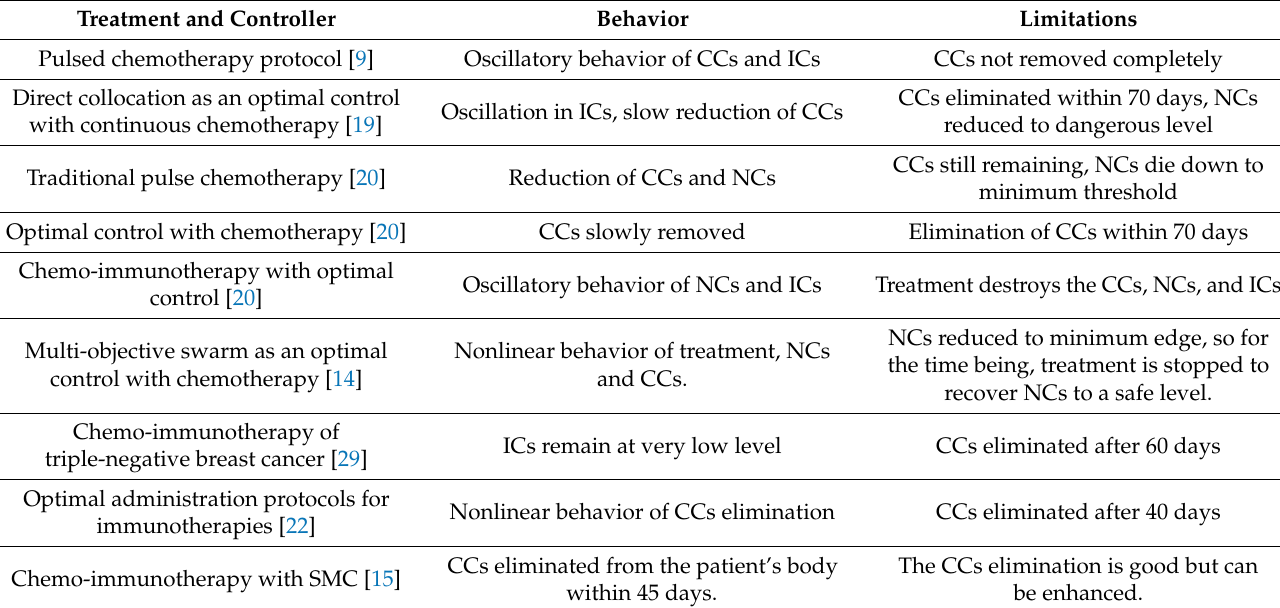
Table 1. Different treatment methods with